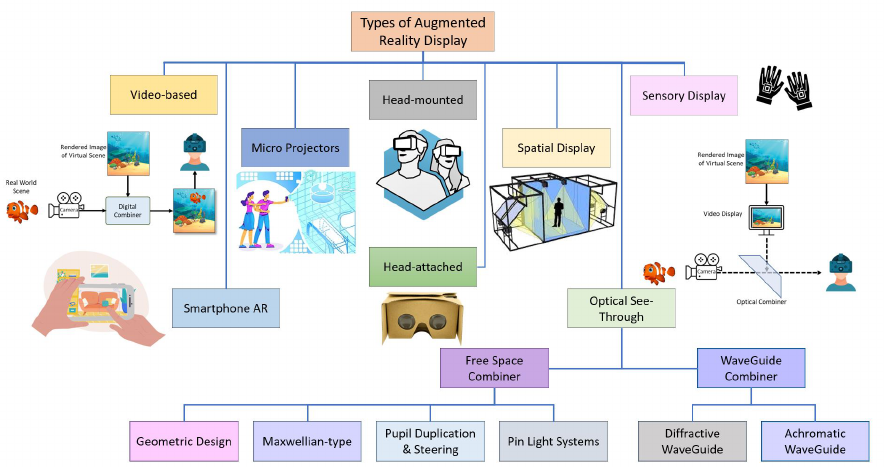
Figure 8. Types of augmented reality display